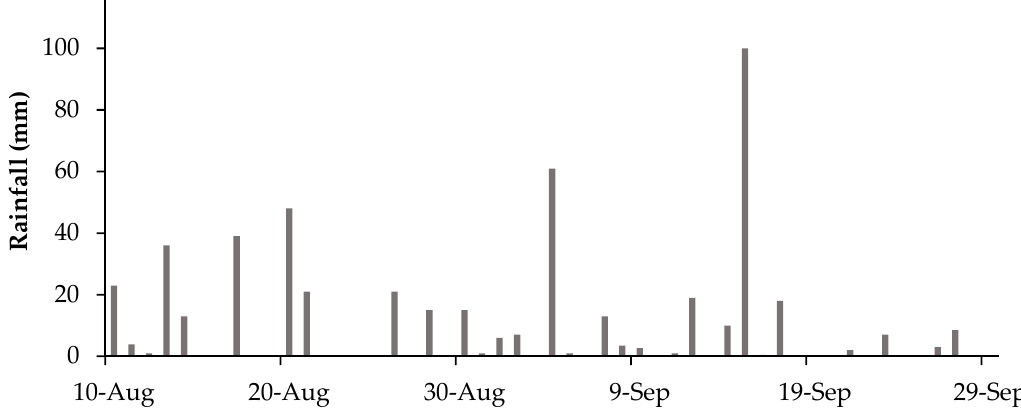
Figure 1. Rainfall distribution and quantity during the 2010 cropping season at Saria Research Station, Burkina Faso.